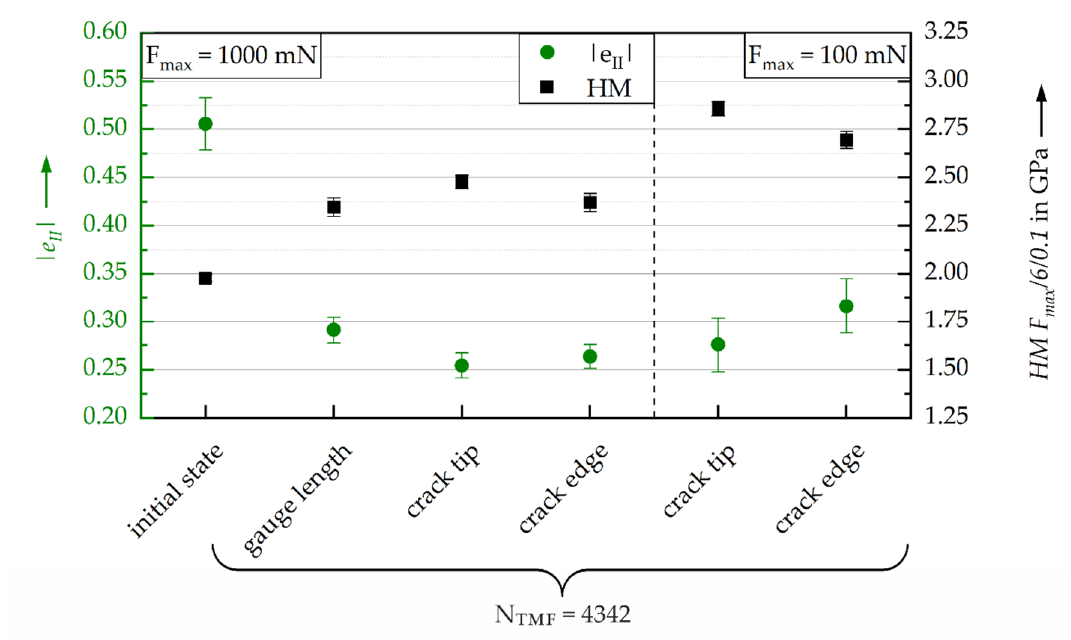
Figure 7. Cyclic hardening exponent CHT | e II | and martens hardness HM at the volume of the gauge length, crack edges and plastic zone in front of the crack tip at a fatigue crack observed at a Crofer ® 22 H specimen loaded for 4342 TMF-cycles.